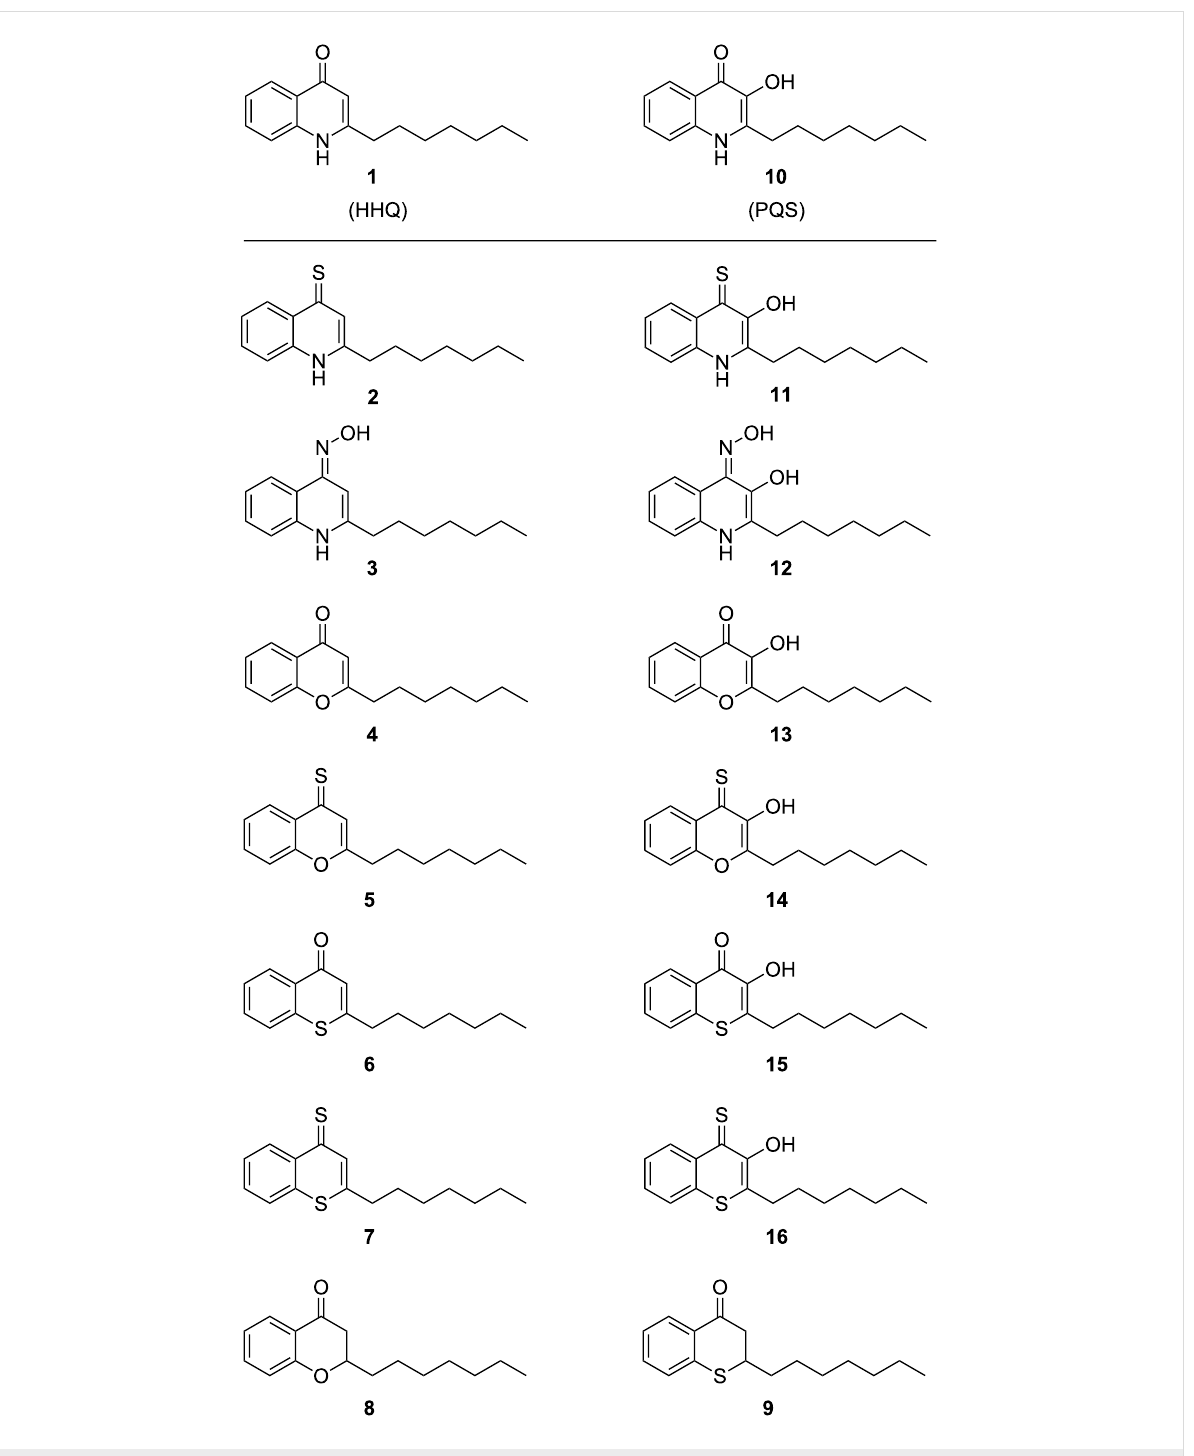
Figure 4: Library of HHQ and PQS analogues.